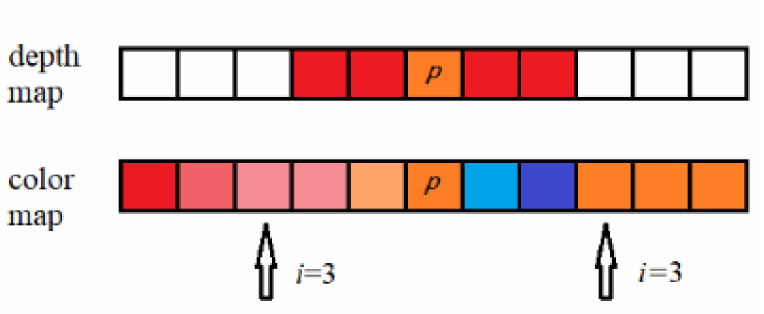
Figure 6. Profile of color difference computation, i.e., i = 3. Pixel p is an outlier. A white pixel has the correct